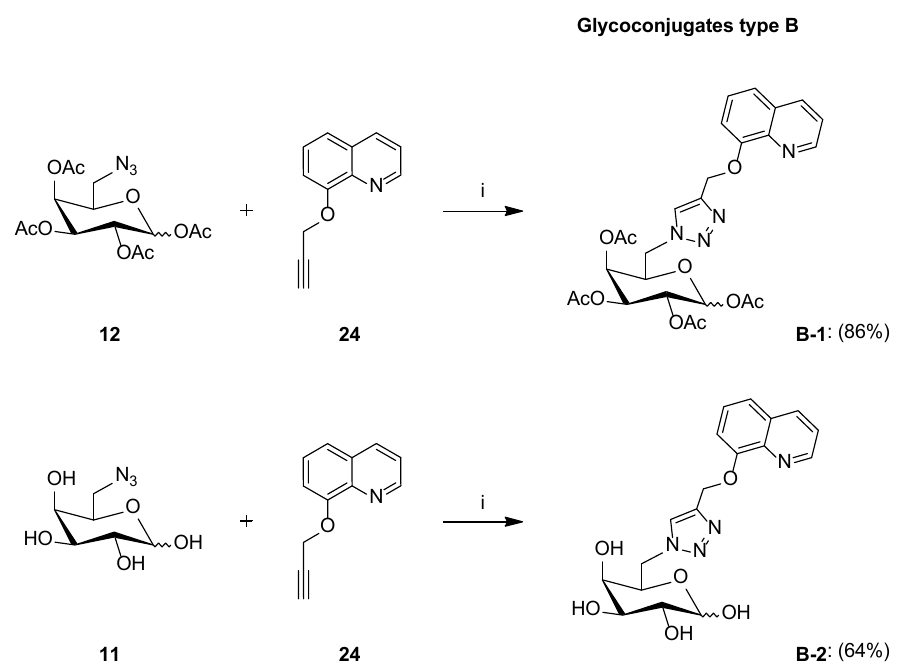
Scheme 6. Synthesis of type B glycoconjugates. Reagents and Conditions: ( i ) CuSO 4 · 5H 2 O, NaAsc, i -PrOH/THF/H 2 O (1:1:1, v : v : v ), r.t., 24 h.